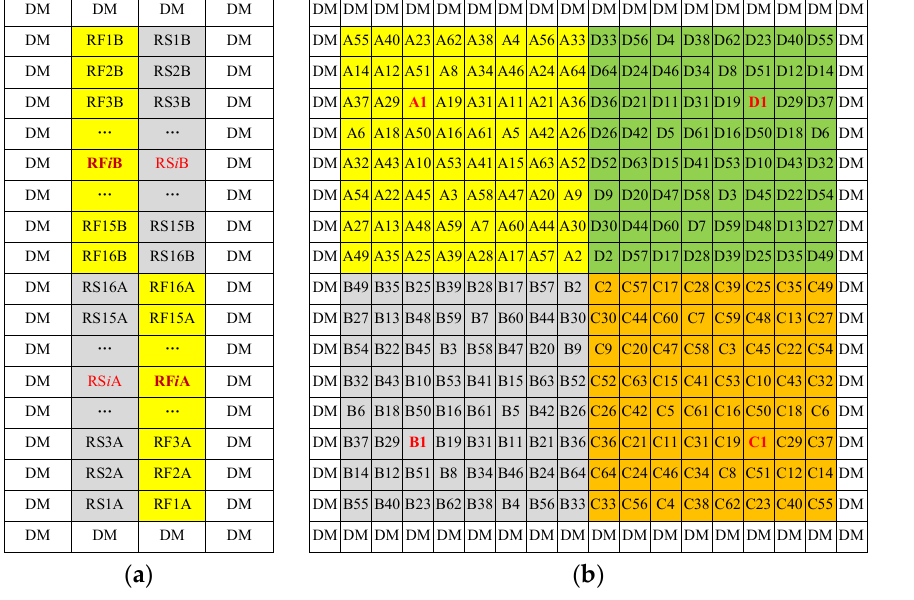
Figure 9. The common-centroid layout of ( a ) matching resistors, unary resistor RS i (RF i ) implemented as two units in red—RS i A (RF i A), and RS i B (RF i B)—in series, where the background color of RS i A (RS i B) and RF i A (RF i B) are gray and yellow, respectively, and ( b ) matching the current sources, unary current sources implemented as four units (A, B, C, and D with background color of yellow, gray, orange and green, respectively) in parallel. For example, current source 1 consists of A1, B1, C1 and D1 in red. DM is the dummy unit.